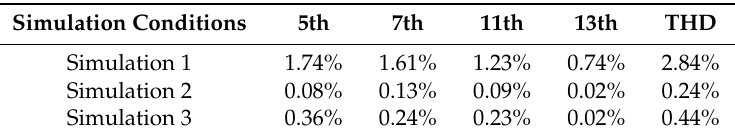
Table 2. The 5th, 7th, 11th, and 13th harmonic variation test data.